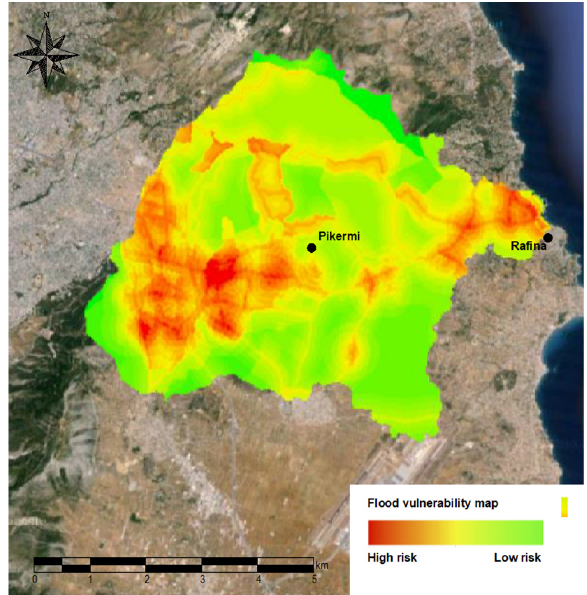
Figure 3. Flood vulnerability map. (Source: FLIRE DSS—http://www.flire.gr, accessed on 5 March 2021, background image: Google Earth).